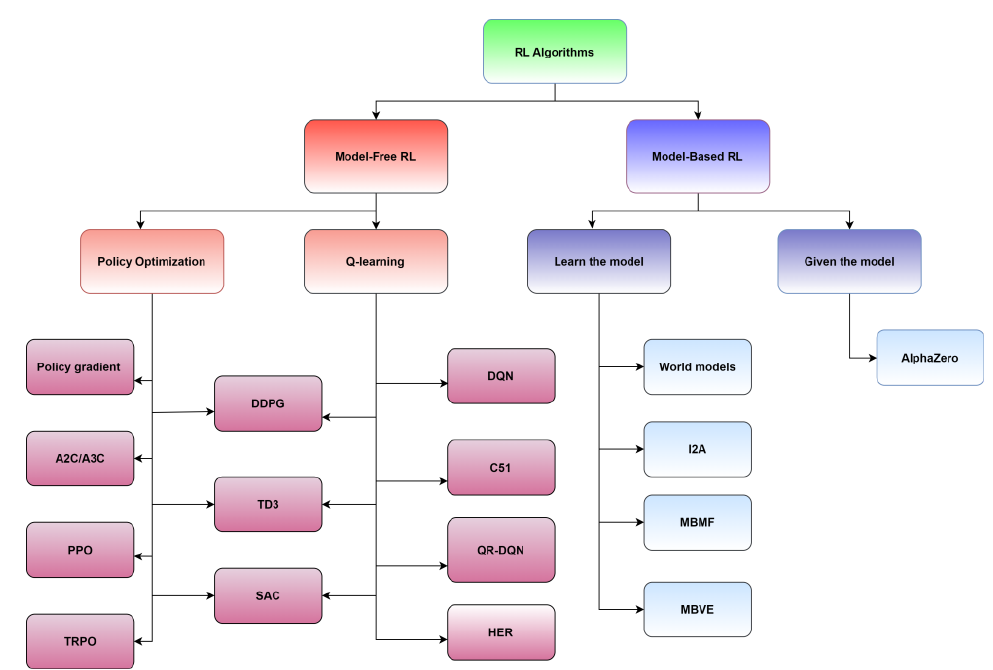
Figure 2. Reinforcement learning algorithm hierarchy .